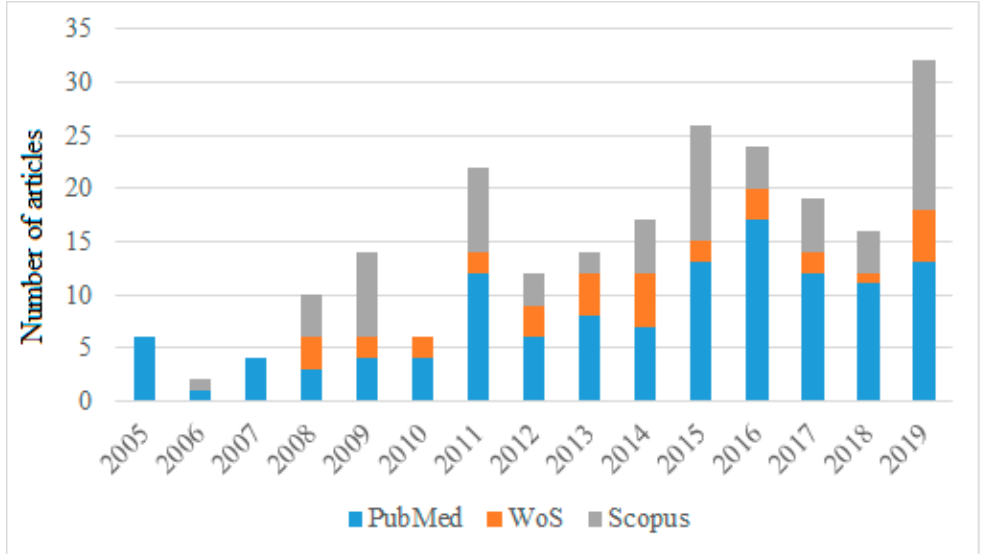
Figure 1. Distribution and progress of papers per year in different databases. WoS: Web of Science.